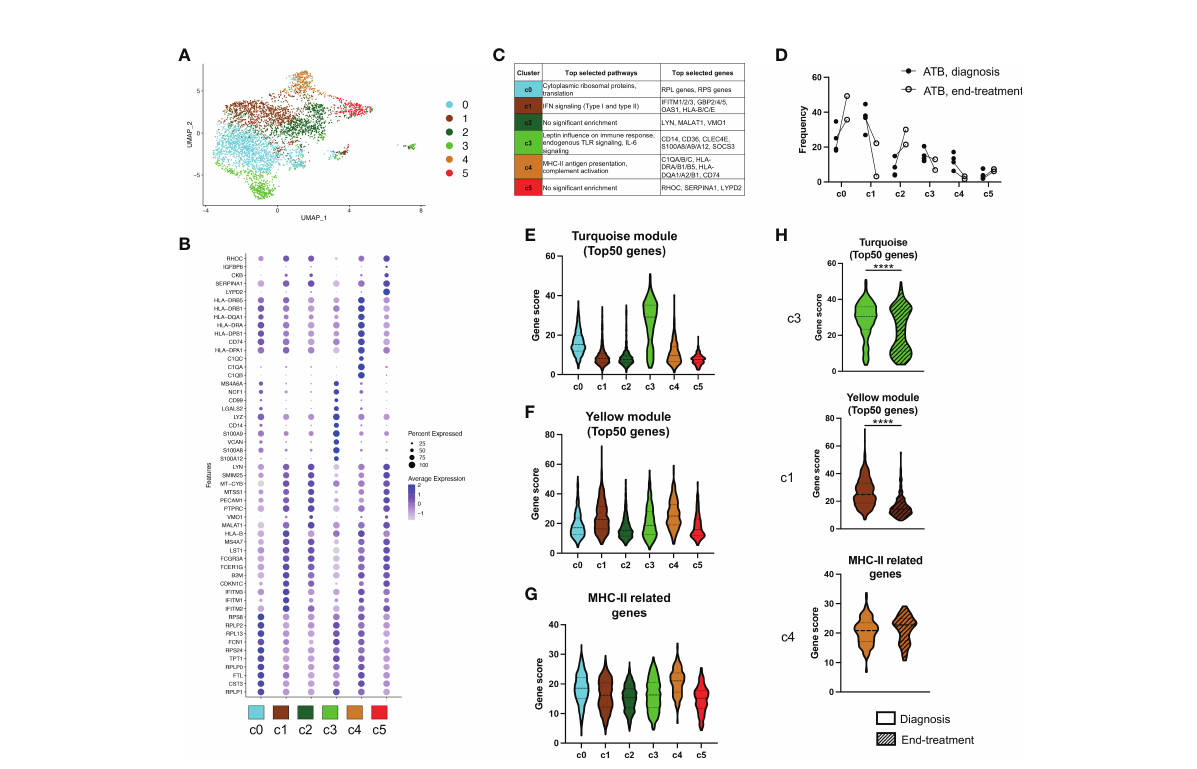
FIGURE 4 Multiple subsets of intermediate CD14 + CD16 + monocytes are contributing to the transcriptomic signature of ATB at diagnosis. (A) UMAP analysis of single-cell RNA sequencing of CD14+CD16+ myeloid cells isolated from cryopreserved PBMC of ATB patients at diagnosis (n=4, visit 1) or end of treatment (n=2, visit 2, paired with visit 1). All cells were divided into six distinct clusters. (B) Dot plot showing the expression of the selected top 10 genes for each of the six clusters identi fi ed in A). (C) Selected top biological pathways enriched and top genes expressed for each cluster. Full list of genes and pathways for each cluster are available in Table S6 and S7. (D) Individual cluster frequency for each ATB patient at diagnosis (Visit 1) and end of treatment (Visit 2). Expression of (E) The turquoise module, (F) The yellow module and (G) MHC-II related genes, in each cluster. (H) Expression of the signatures shown in E-G split by sample visit (diagnosis vs end-treatment). For each signature, expression was only shown for the cluster with highest expression as depicted in E-G (i.e., cluster 3 for the turquoise module, cluster 1 for the yellow module, and cluster 4 for MHC-II related genes). The turquoise module, yellow module and MHC-II related gene signatures were identi fi ed in our bulk RNA sequencing analysis as represented in Figures 2 and 3. Gene scores were calculated by summing all genes composing the signature, or the top 50 genes for the modules. ****p < 0.0001, nonparametric unpaired Mann-Whitney U